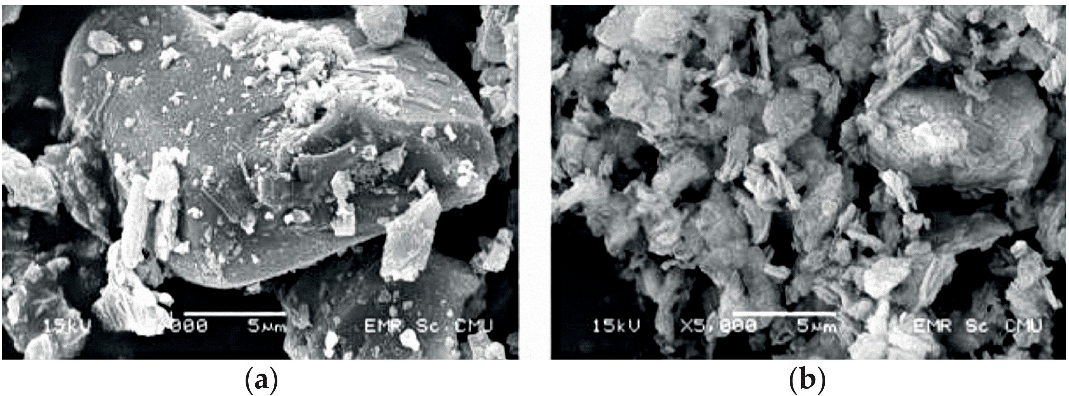
Figure 3. SEM photo of ( a ) mixture of CEM grains (big particles) and ( b ) metakaolin grains (small particles) [28].